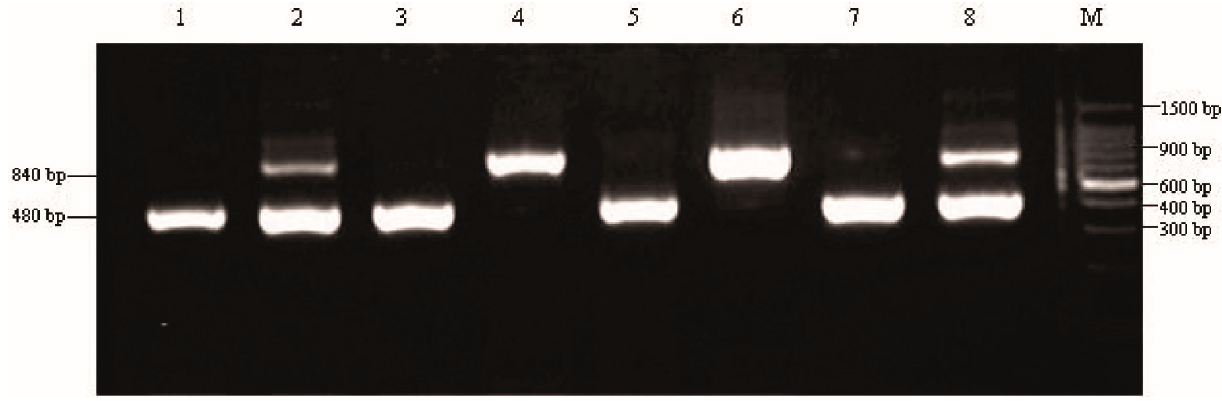
Figure 3. The polymerase chain reaction (PCR) characterization profiles of the genotypes of C. albicans. 25s rDNA. Lanes 1 , 3 , 5 and 7 were for genotype A, and the size of the PCR products was approximately 450 bp; Lanes 4 and 6 were for genotype B, and the size of the PCR products was approximately 840 bp; Lanes 2 and 8 were for genotype C, and the sizes of the two PCR products were approximately 450 and 840 bp.